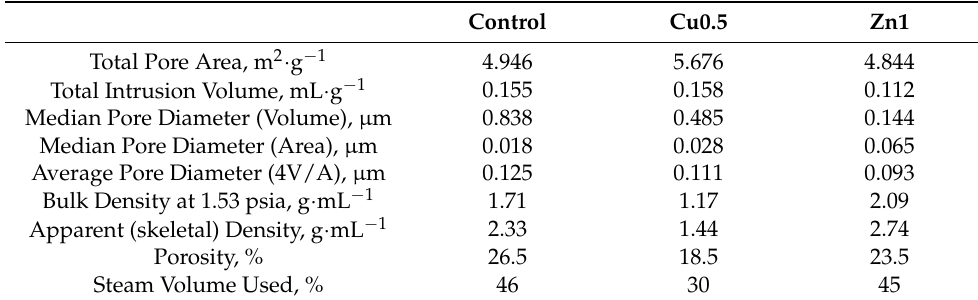
Table 4. Mercury intrusion porosimetry (MIP)